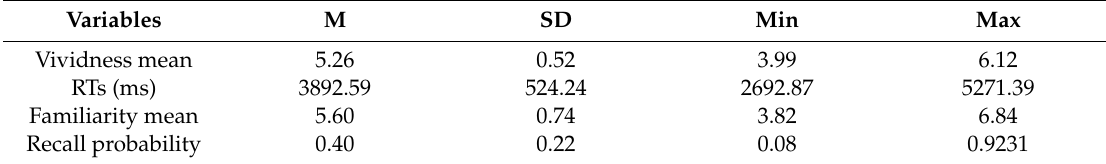
Table 1. The descriptive information of the experimental variables.